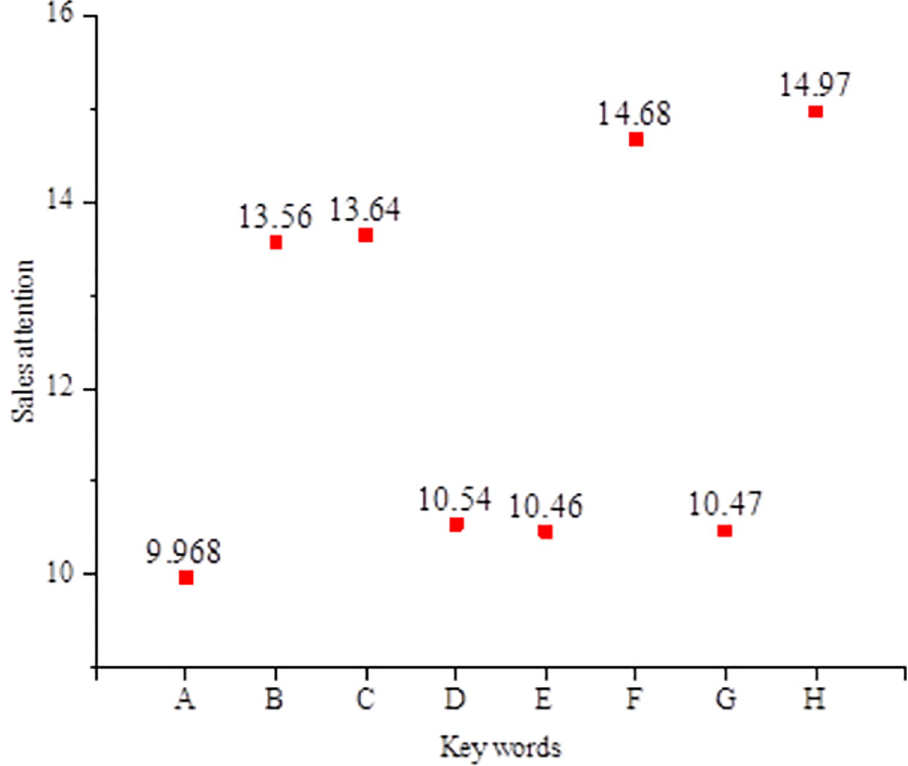
Fig 6. Experimental data analysis of sales attention (A: product category; B: total customer demand; C: customer buying psychology; D: product life; E: in stock; F: price; G: Logistics; H: risk).